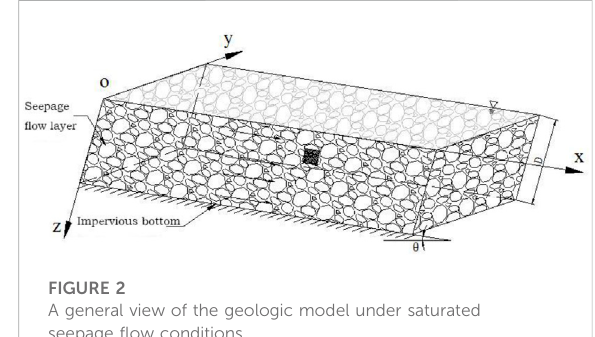
FIGURE 2 A general view of the geologic model under saturated seepage fl ow